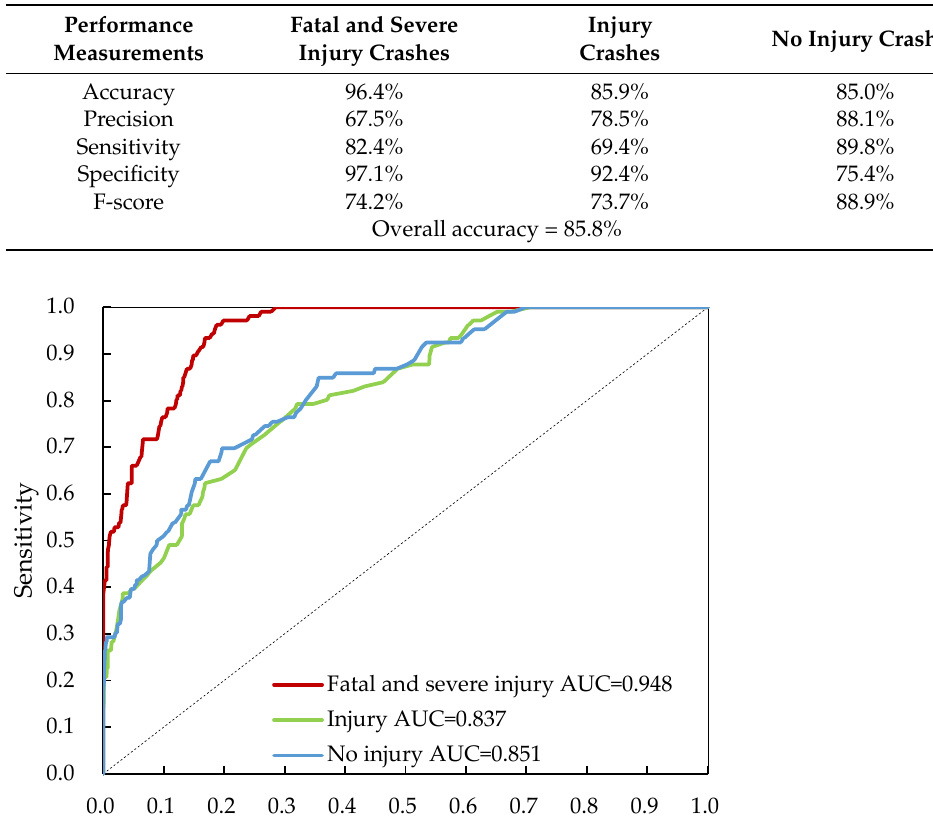
Table 4. Performance measurements for the Bayesian network model.